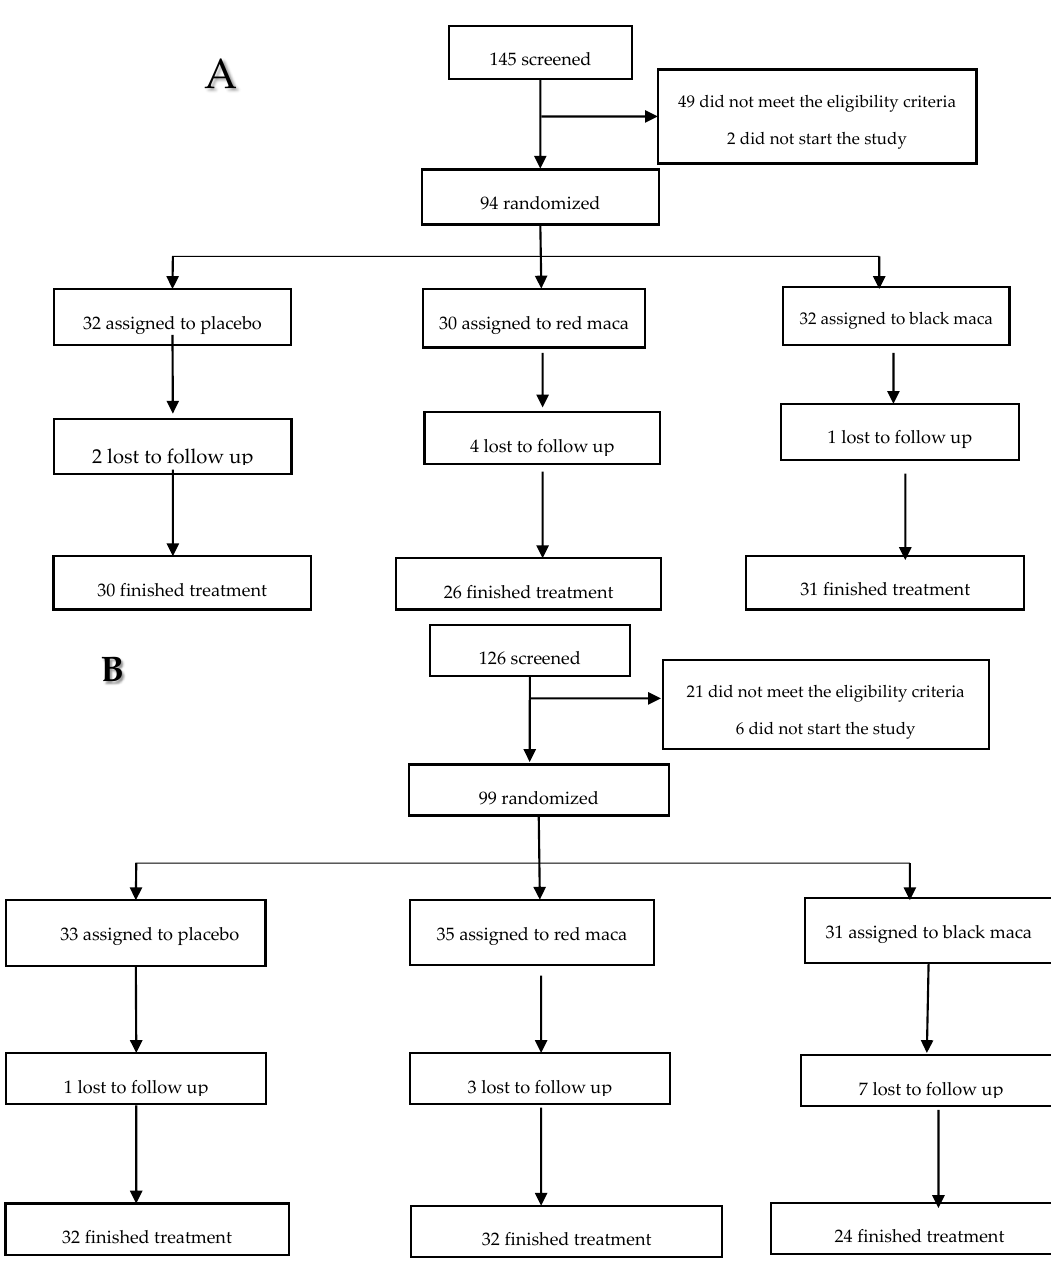
Figure 6. Flow diagram following the recruitment, enrollment, and number of subjects that finished treatment of the clinical trial at low altitude ( A ) and high altitude ( B ). Low altitude: Chi square: 0.11; p = 0.99 with respect to subjects who failed to complete the follow-up among different groups of treatment. High altitude: Chi square: 0.6; p = 0.99 with respect to subjects who failed to complete the follow-up among different treatment